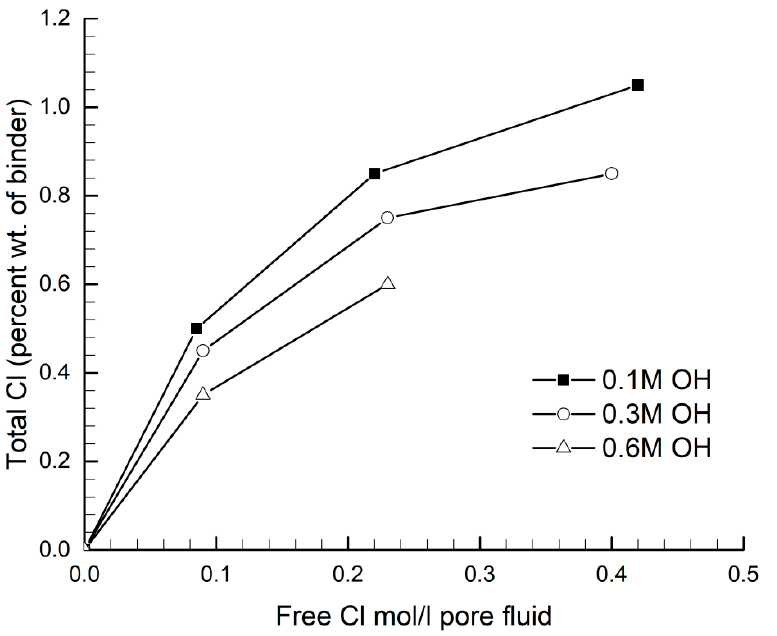
Figure 2. Effect of hydroxyl ion concentration on chloride binding for OPC pastes with water–cement ratio of 0.40 [54].